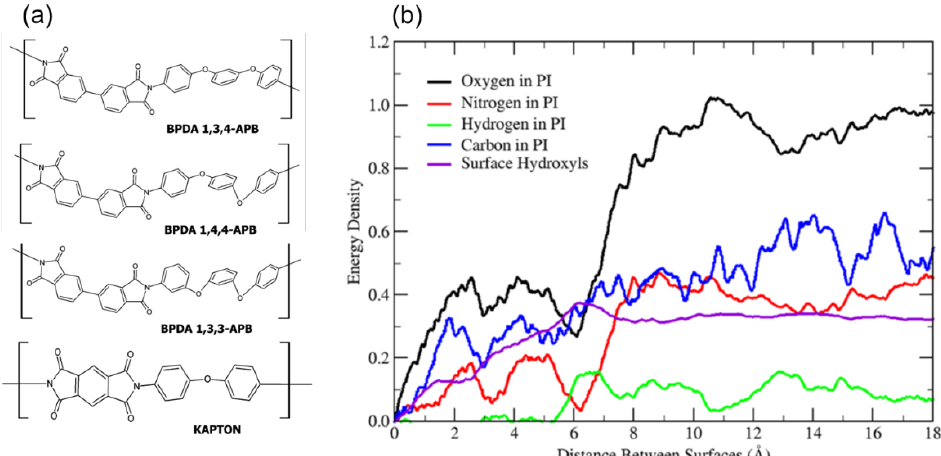
Figure 4. ( a ) Chemical structure of polyimide monomers for three BPDAs and Kapton. ( b ) Energy density profile for atomic subgroups in the polyimide (adapted with permission from Reference [25], Copyright 2016 American Chemical Society).